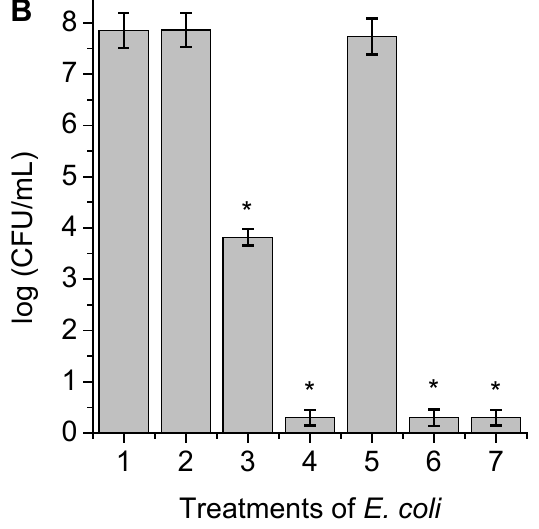
Figure 5. Survival of bacteria (~ 10 8 CFU/mL) incubated with PZnTEP for 30 min at 37 °C in the dark and irradiated with white light for different times. ( A ) S. aureus : (1) dark control, (2) 0.5 µ M PZnTEP in dark, (3) 0.5 µ M PZnTEP and 15 min irradiation, (4) 0.5 µ M PZnTEP and 30 min irradiation, (5) 1.0 µ M PZnTEP in dark, (6) 1.0 µ M PZnTEP and 15 min irradiation, (7) 1.0 µ M PZnTEP and 30 min irradiation; ( B ) E. coli : (1) dark control, (2) 1.0 µ M PZnTEP in dark, (3) 1.0 µ M PZnTEP and 15 min irradiation, (4) 1.0 µ M PZnTEP and 30 min irradiation, (5) 1.0 µ M PZnTEP + 100 mM KI in dark, (6) 1.0 µ M PZnTEP + 100 mM KI and 15 min irradiation, (7) 1.0 µ M PZnTEP + 100 mM KI and 30 min irradiation (* p < 0.05 compared with control).